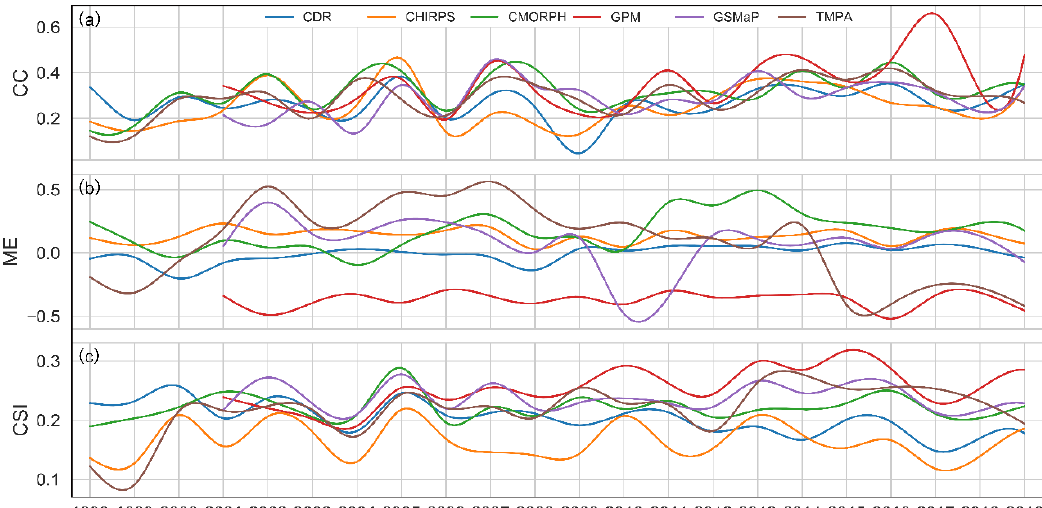
Figure 8. Smooth line chart of the distribution of the evaluation indexes in every year from 1998 to 2019 based on NW station daily data. ( a ) Correlation coefficient, ( b ) mean error, ( c ) critical success index.